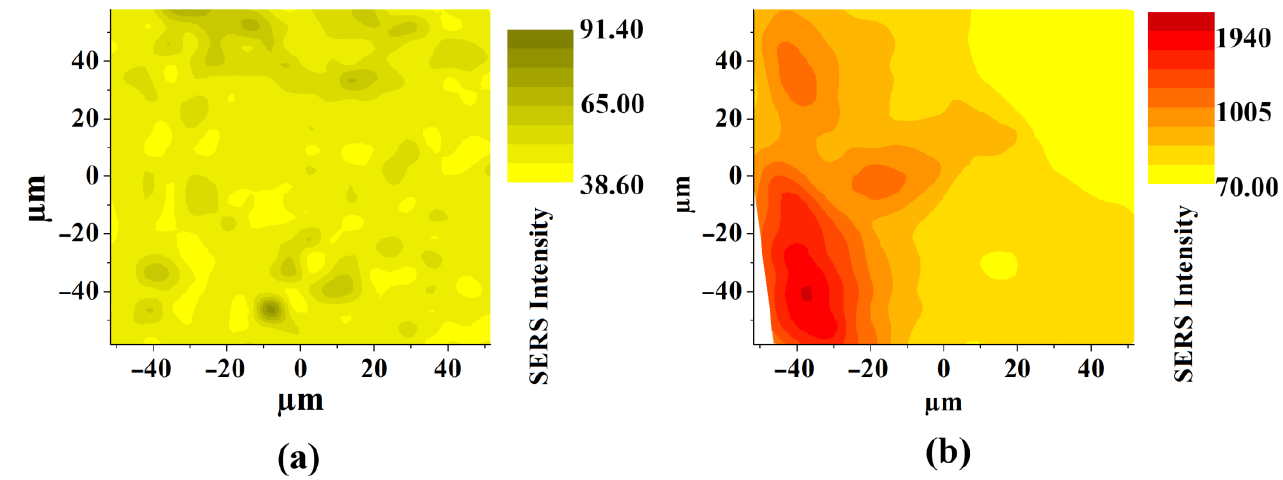
Figure 10. SERS spectrum distribution maps recorded on the ( a ) Ti 3D with 0.02 mg/cm 2 silver deposit, ( b ) Ti 3D with TiO 2 nanotubes and Ag deposit (0.02 mg/cm 2